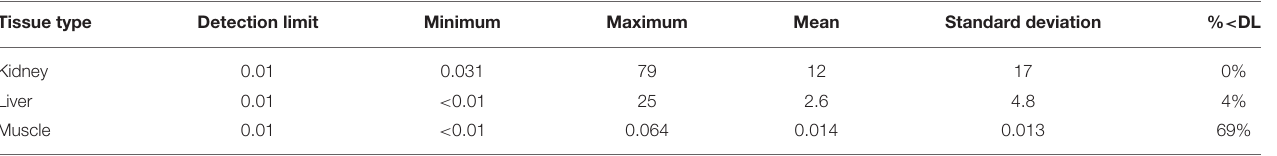
TABLE 5 | CPDFN summary statistics ( n = 26).